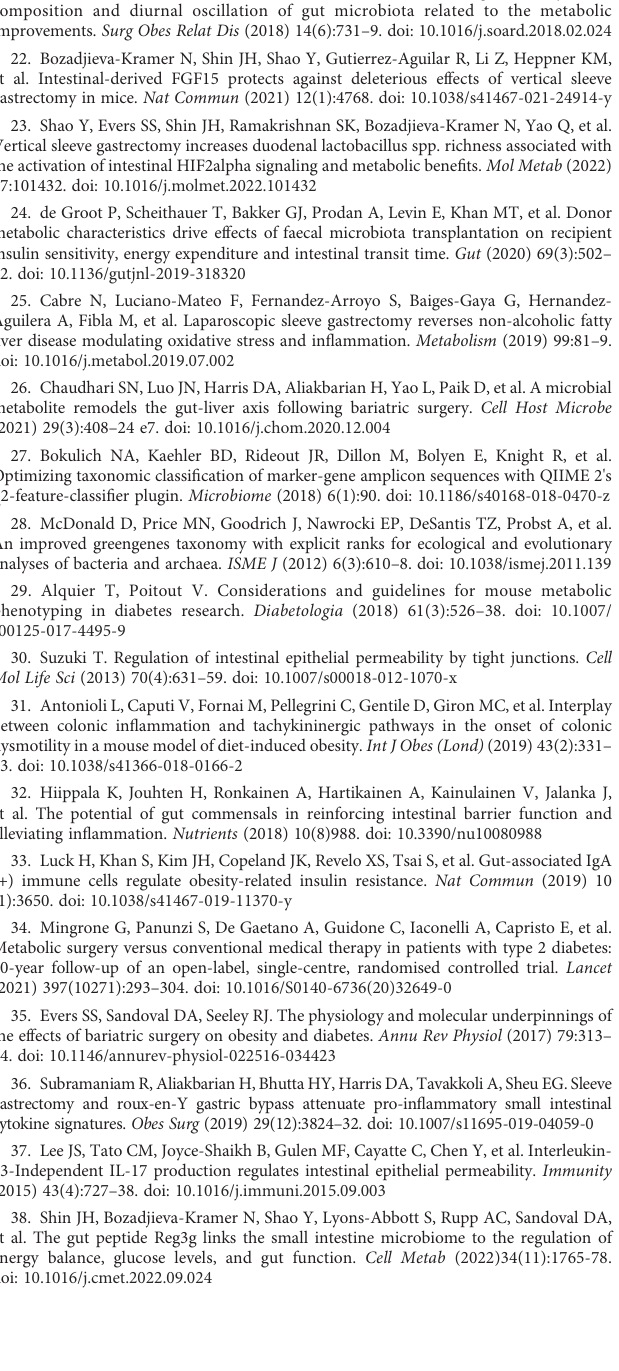
SUPPLEMENTARY FIGURE 4 Comparisons in mRNA expression levels of in fl ammatory cytokines and tight junction proteins as well as macrophage in fi ltration in the colon among four surgical groups. (A) . Genes expressions of in fl ammatory cytokines in the colon. (B) Gene expressions of tight junction proteins in the colon. (C) Quanti fi cation of CD68 positive cells. (D) Gene expressions of macrophages markers in the colon. n = 7-9/group; Data are presented as means ± SEM. Two-way ANOVA